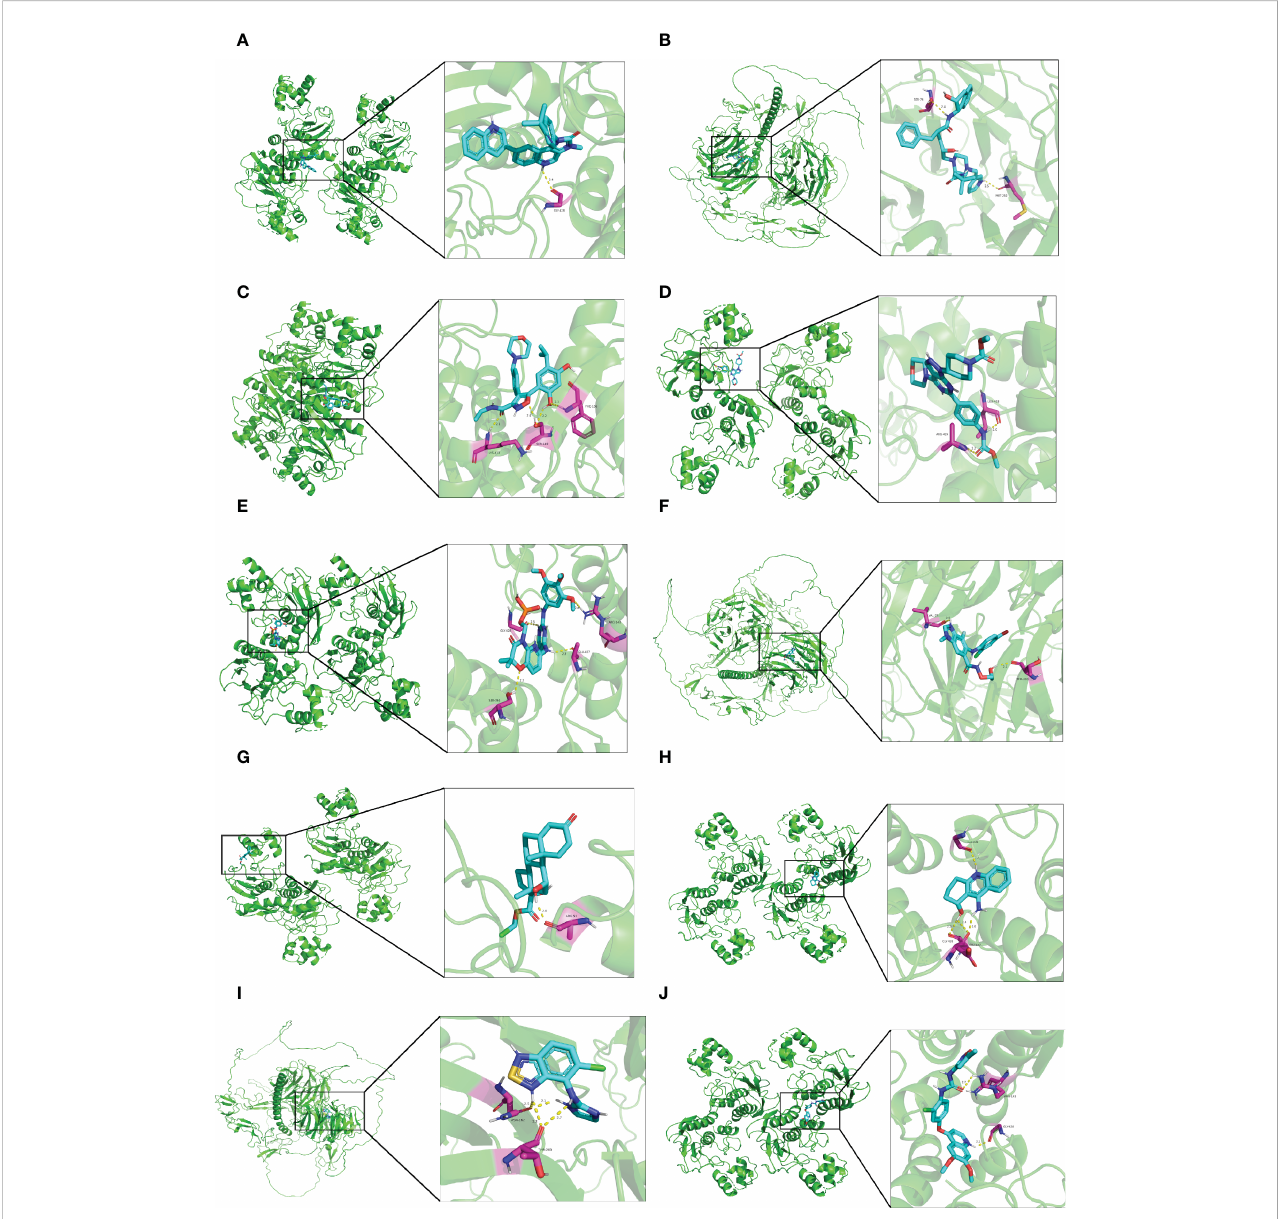
FIGURE 8 Molecular docking diagram of small molecule drugs and target genes. (A) dactolisib-MMP9 (B) indinavir-EGF (C) NVP-AUY922-MMP9 (D) WYE-354- MMP9 (E) fostamatinib-MMP9 (F) selumetinib-MMP9 (G) loteprednol-MMP9 (H) velnacrine-MMP9 (I) tizanidine-EGF (J)